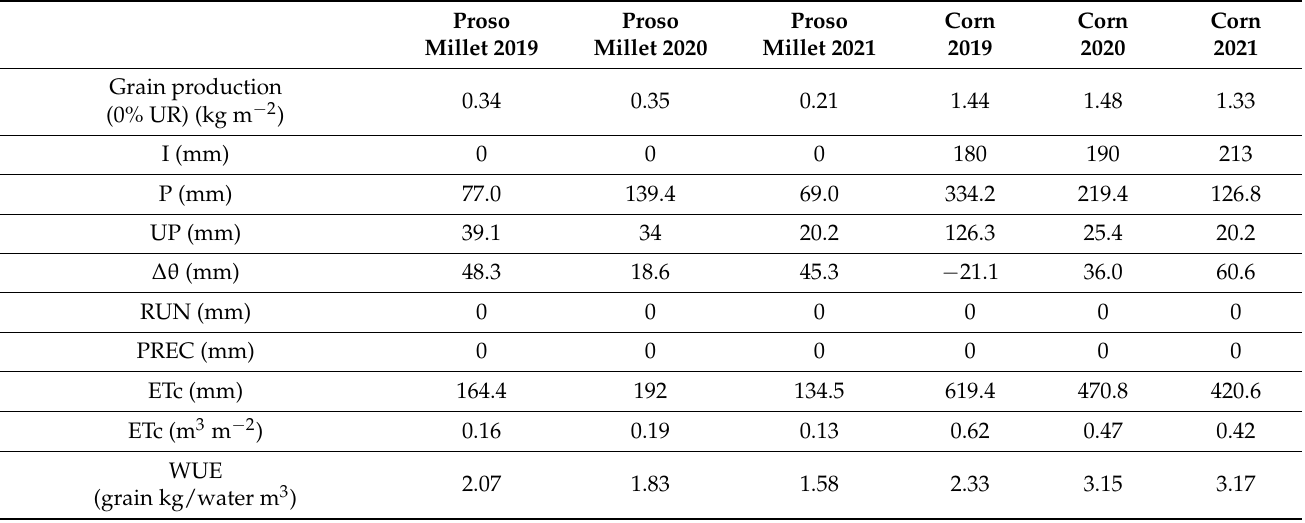
Table 5. Proso millet and corn water balance and WUE in 2019, 2020, and 2021 (VM and AC site, respectively). Proso